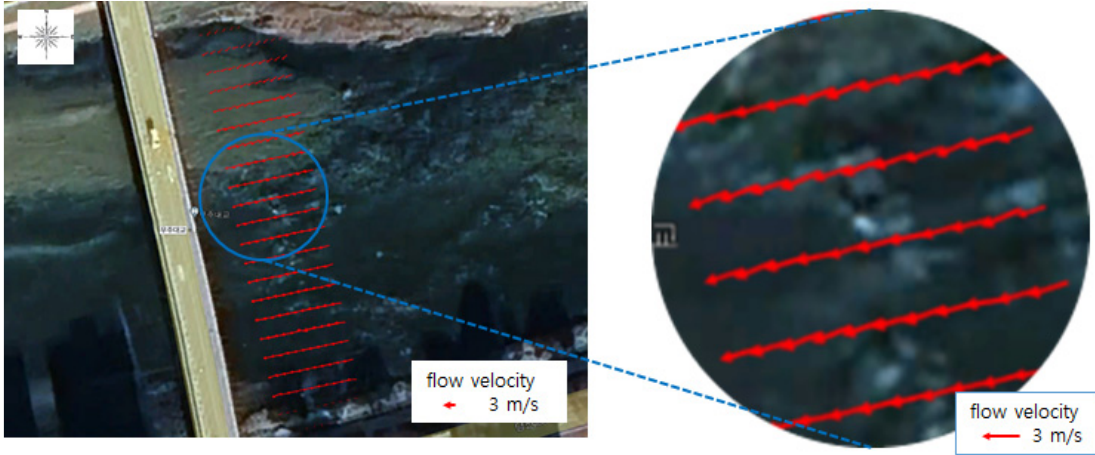
Figure 10. Velocity fields (Mujudaegyo Bridge) plotted in Google Maps.